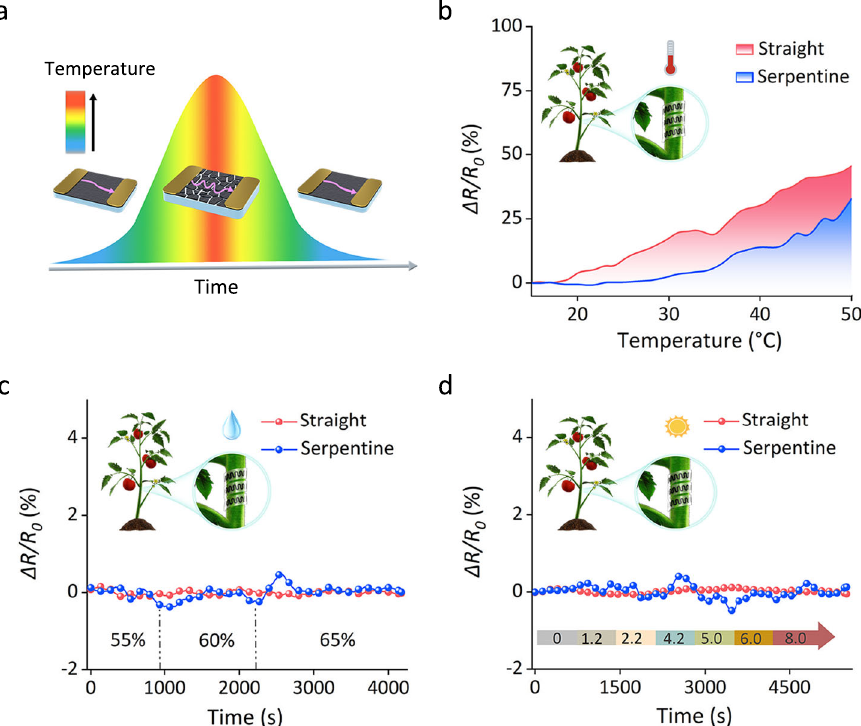
Fig. 5 Anti-environmental interference performance. a Schematic of thermal expansion of AWS sensor. b The response of straight-patterned AWS sensor and serpentine-patterned AWS sensor at different temperatures. c The response of straight-patterned AWS sensor and serpentine- patterned AWS sensor at different humidity (55%, 60%, and 65%). d The response of straight-patterned AWS sensor and serpentine-patterned AWS sensor at different illumination intensity (0 – 8